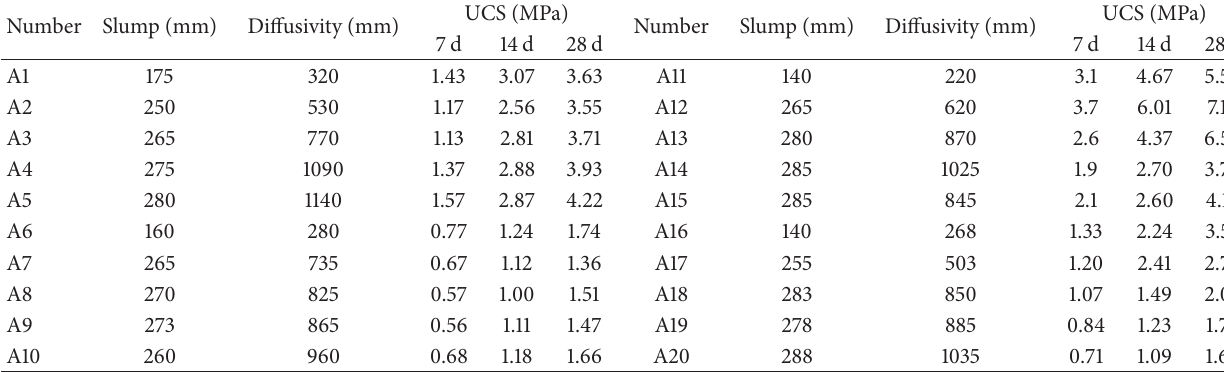
Table 2: The results of the first